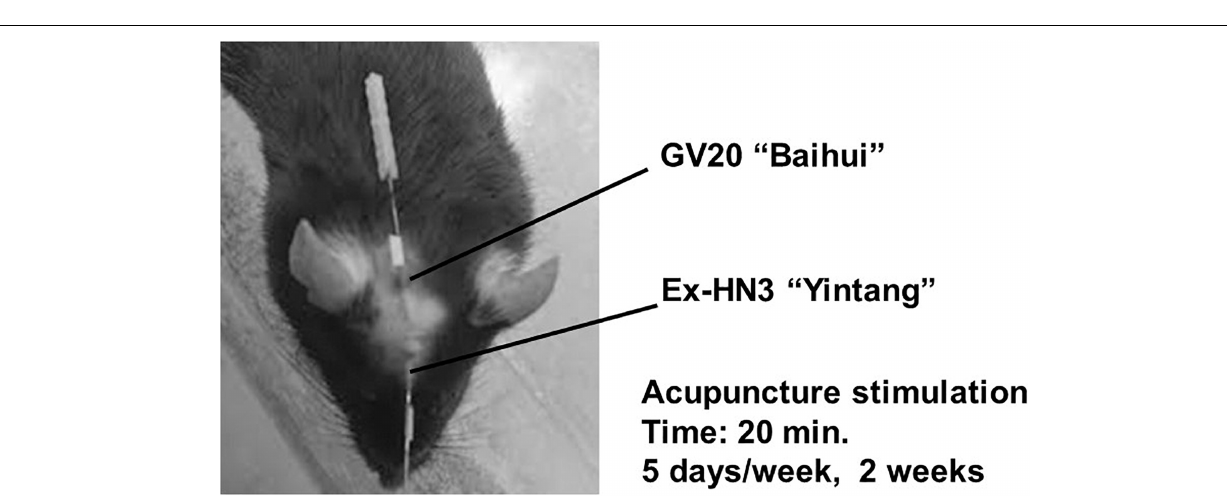
FIGURE 2 | The schedule of the “therapeutic effect” experiment. The timeline of the procedures for the “therapeutic” group conditions. AP, acupuncture; BW, body weight; ELISA, enzyme-linked immuno sorbent assay; FST, forced swimming test; PCR, polymerase chain reaction; SDS, social defeat stress.